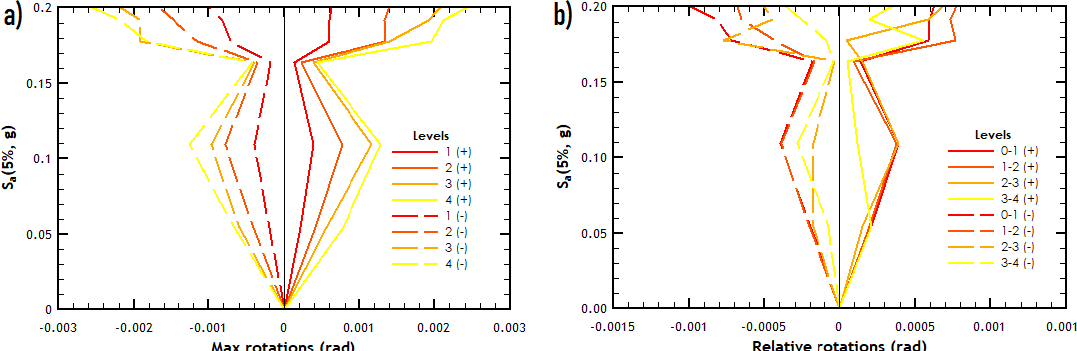
Figure 15. Variations in the ( a ) maximum rotations and ( b ) relative rotations of the center of gravity for each floor calculated for various values of spectral acceleration and 5% critical damping.